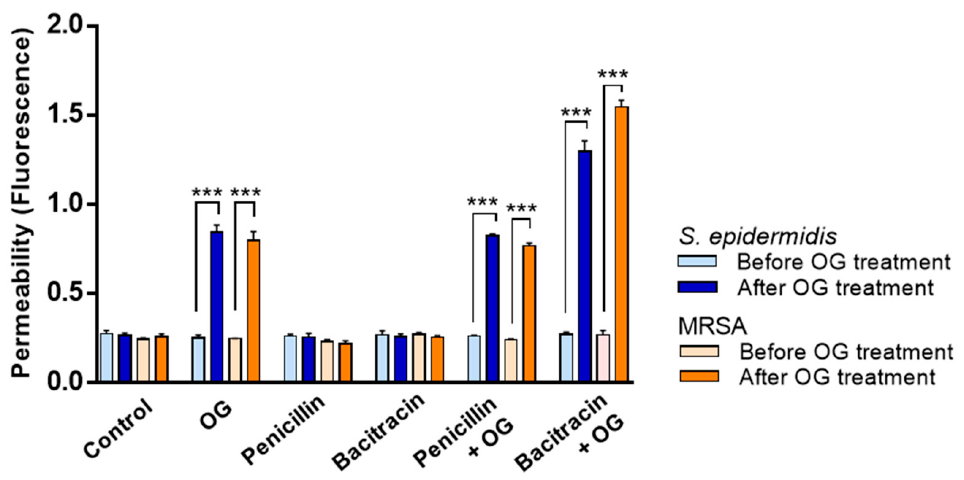
Figure 2. Increased cell wall permeability by octyl gallate (OG) in Staphylococcus epidermidis and methicillin-resistance Staphylococcus aureus (MRSA). The results show the means and standard deviations of fluorescence values of propidium iodide from three samples in a single experiment before and after addition of 40 µg/mL OG or PBS (control). The experiment was repeated three times and produced similar results. The concentrations of penicillin and bacitracin used in the assay were 4 µg/mL and 4 IU/mL, respectively. One-way ANOVA followed by Bonferroni's Multiple Comparison Test was used for statistical analysis. ***: p < 0.01.